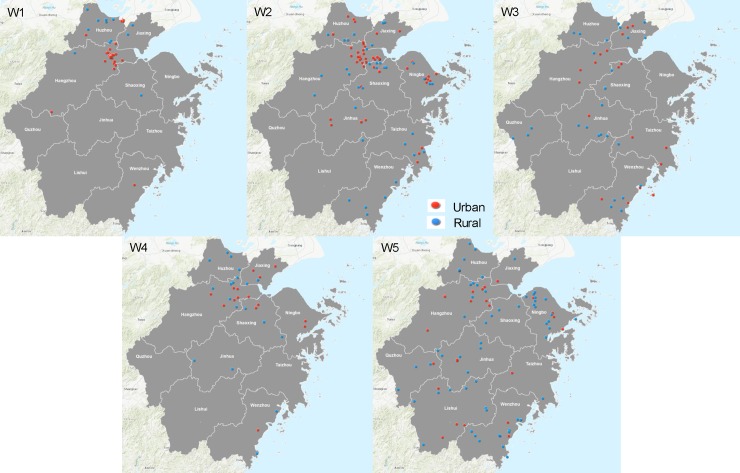
Spatial distribution of urban (red) and rural (blue) H7N9 infections from the first to the fifth epidemic waves (W1 to W5) from April 2013 to June 2017 in the Zhejiang province, China.W1: First wave (April 3—April 27, 2013); W2: Second wave (October 15, 2013—June 16, 2014); W3: Third wave (November 26, 2014—June 2, 2015); W4: Forth wave (September 26, 2015—June 29, 2016); W5: Fifth wave (October 8, 2016—June 12, 2017).